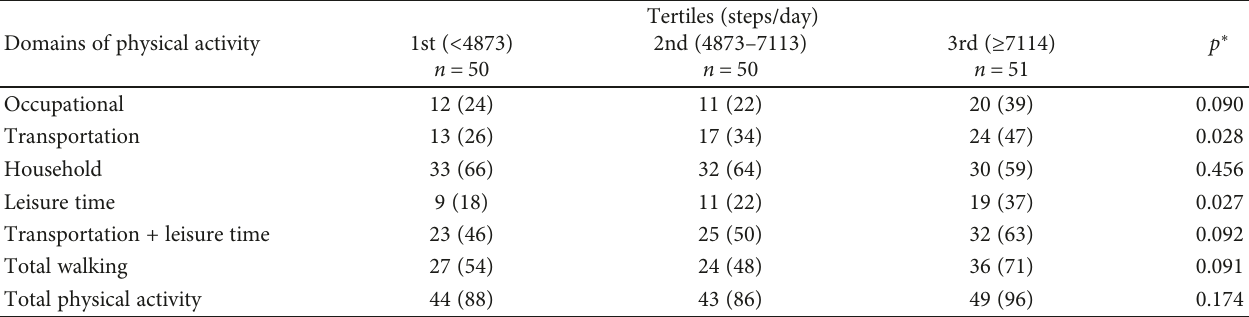
Table 3: Frequency of active individuals based on IPAQ results ( ≥ 150min/week) strati fi ed by step count tertiles. Domains of physical